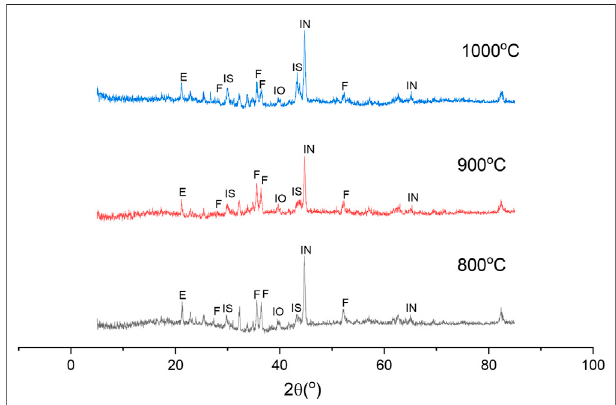
FIGURE 8 | XRD patterns of roasted ores under different reduction roasting temperatures: (IN) Iron-Nickel, (IS) FeS, (F) Na 2 Mg 2 Si 2 O 8 Forsterit,(E) Enstatite, (IO) Iron Oxide.